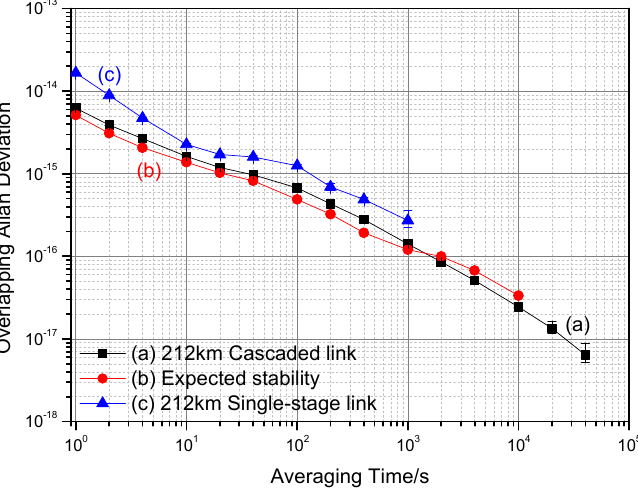
Figure 9. Dissemination stability of the 212 km urban link.